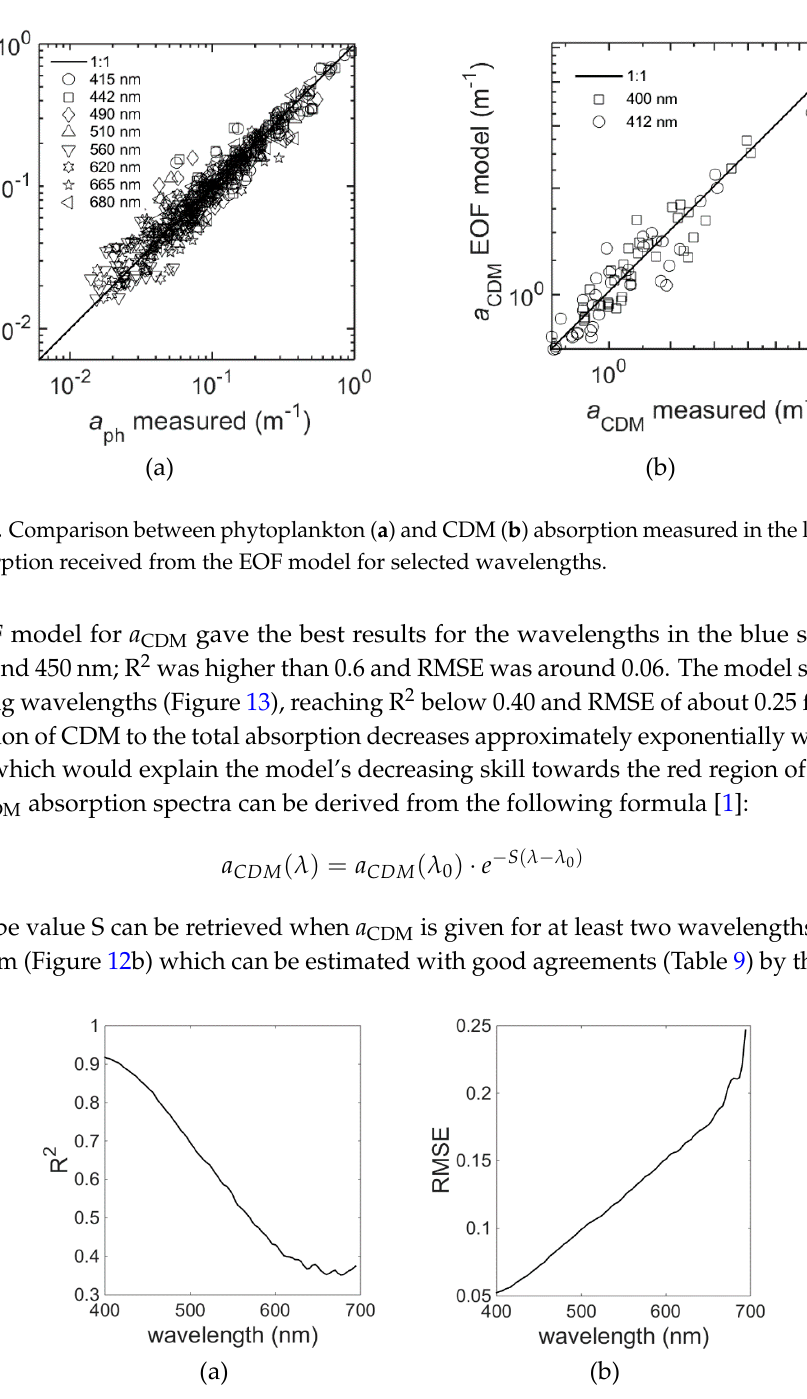
Figure 13. Spectral dependence of R 2 ( a ) and RMSE ( b ) for the EOF model of a CDM.